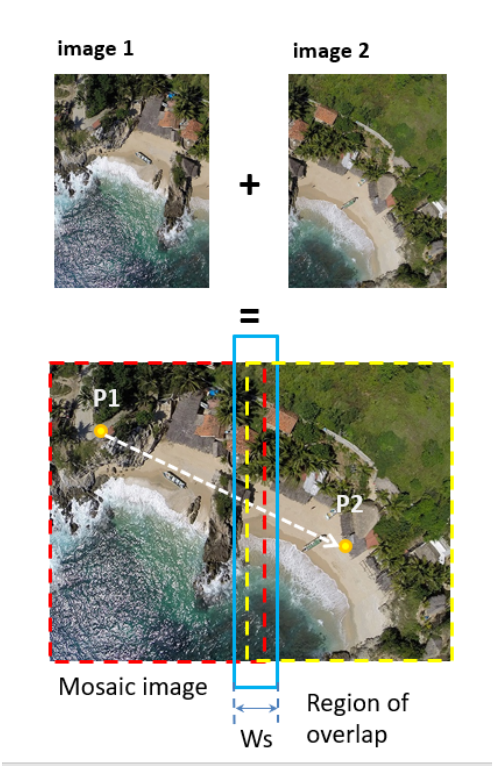
Figure 1. Distance between two points in image mosaicing the shared region from the left and right original (narrow-view) images and the mosaic. SURF points are then extracted. Figure 2 shows the entire set of points extracted from an image of the imageset under analysis.